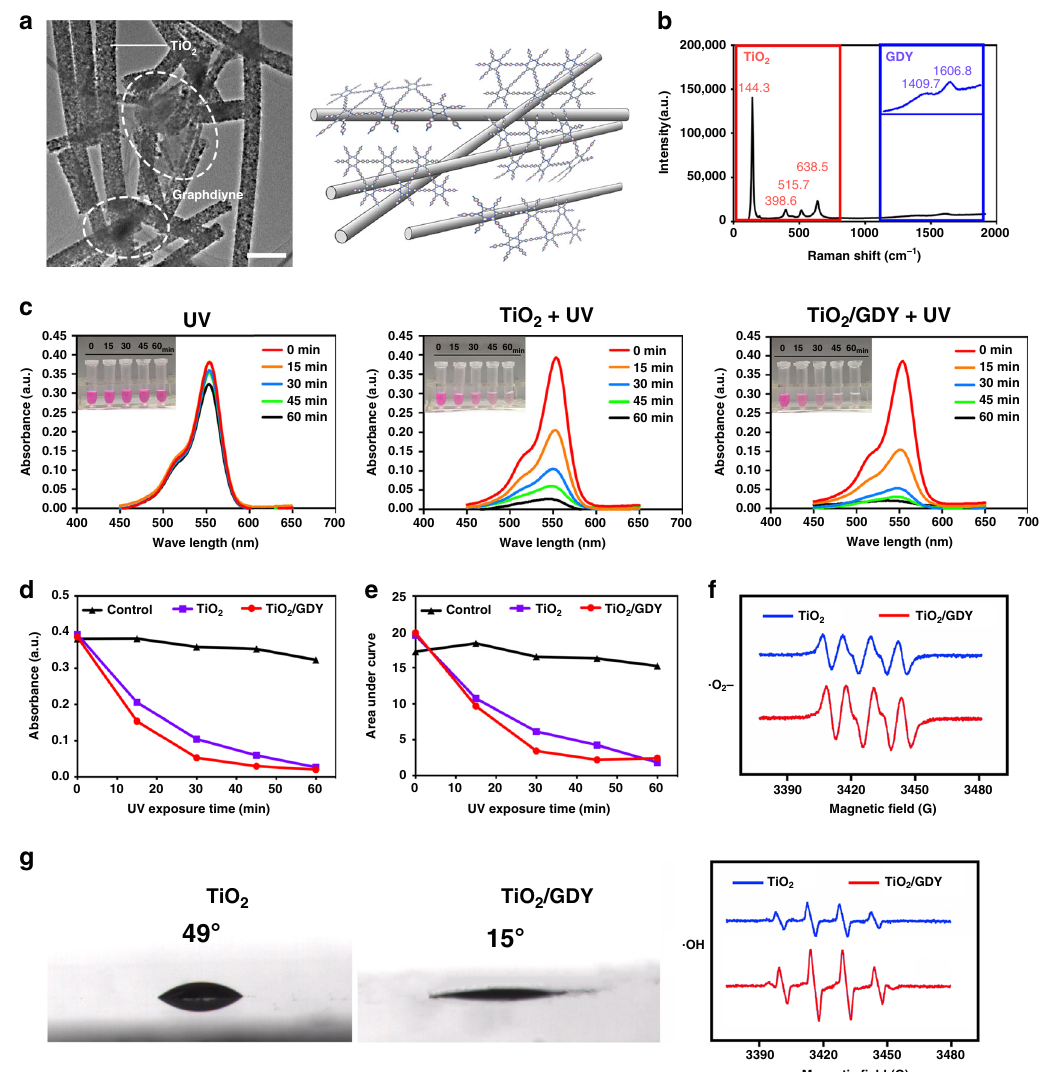
Fig. 1 Characterization and photocatalytic properties of TiO 2 /GDY. a Transmission electron microscopy image of TiO 2 /GDY (left, scale bar = 0.5 μ m) ( n = 3 separate materials) and illustration of the TiO 2 /GDY structure (right). b Raman spectra of TiO 2 /GDY. The main peaks of TiO 2 are shown in the red box, and the magni fi ed peaks of GDY are shown in blue. c Absorption curves and photos of rhodamine B degradation by TiO 2 and TiO 2 /GDY photocatalysis under UV irradiation for different times (0, 15, 30, 45, and 60 min). d Trends in the absorbance peaks of the RhB curves at each UV exposure time point. e Areas under the absorption curves at each time point. f Electron spin resonance for (cid:129) OH (below) and (cid:129) O 2 − (above) generation after TiO 2 (blue) and TiO 2 /GDY (red) were induced by UV. g Contact angle measurements of TiO 2 and TiO 2 /GDY nano fi bers. Source data of b – f are provided as a Source Data fi (Fig. 2d – f). TiO 2 /GDY produced few dead cells (red) with or